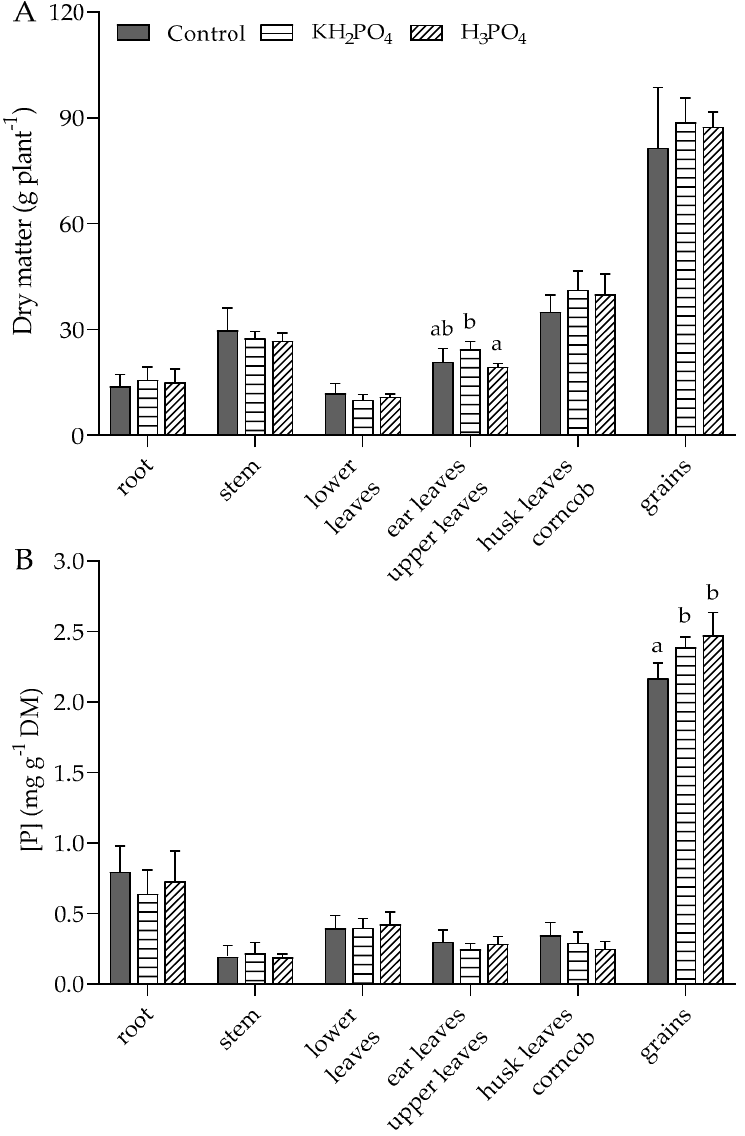
Figure 4. ( A ) Dry matter in g plant − 1 and ( B ) phosphorus concentration (P) in mg g − 1 dry matter of the investigated parts of the plant were analyzed after harvest at maturity (BBCH 89). Plant material was separated into root, stem, lower leaves (leaves below the ear leaves), ear leaves and upper leaves, husk leaves and corncob, and grains. Control without P fertilization (control) and three foliar applications of 200 mM potassium dihydrogen phosphate (KH 2 PO 4 ) or phosphoric acid (H 3 PO 4 ) at 40, 46, and 53 days after sowing. Bars represent means + SD ( n = 5). Upper and lower case letters indicate significant differences between treatments within the examined parameters (ANOVA with Duncan test, p ≤